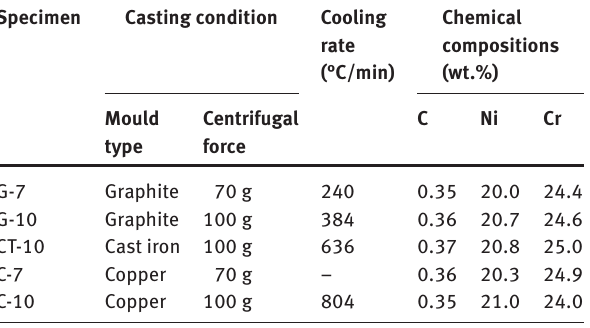
Table 5: Chemical compositions of Ti and Nb added HK40 steels